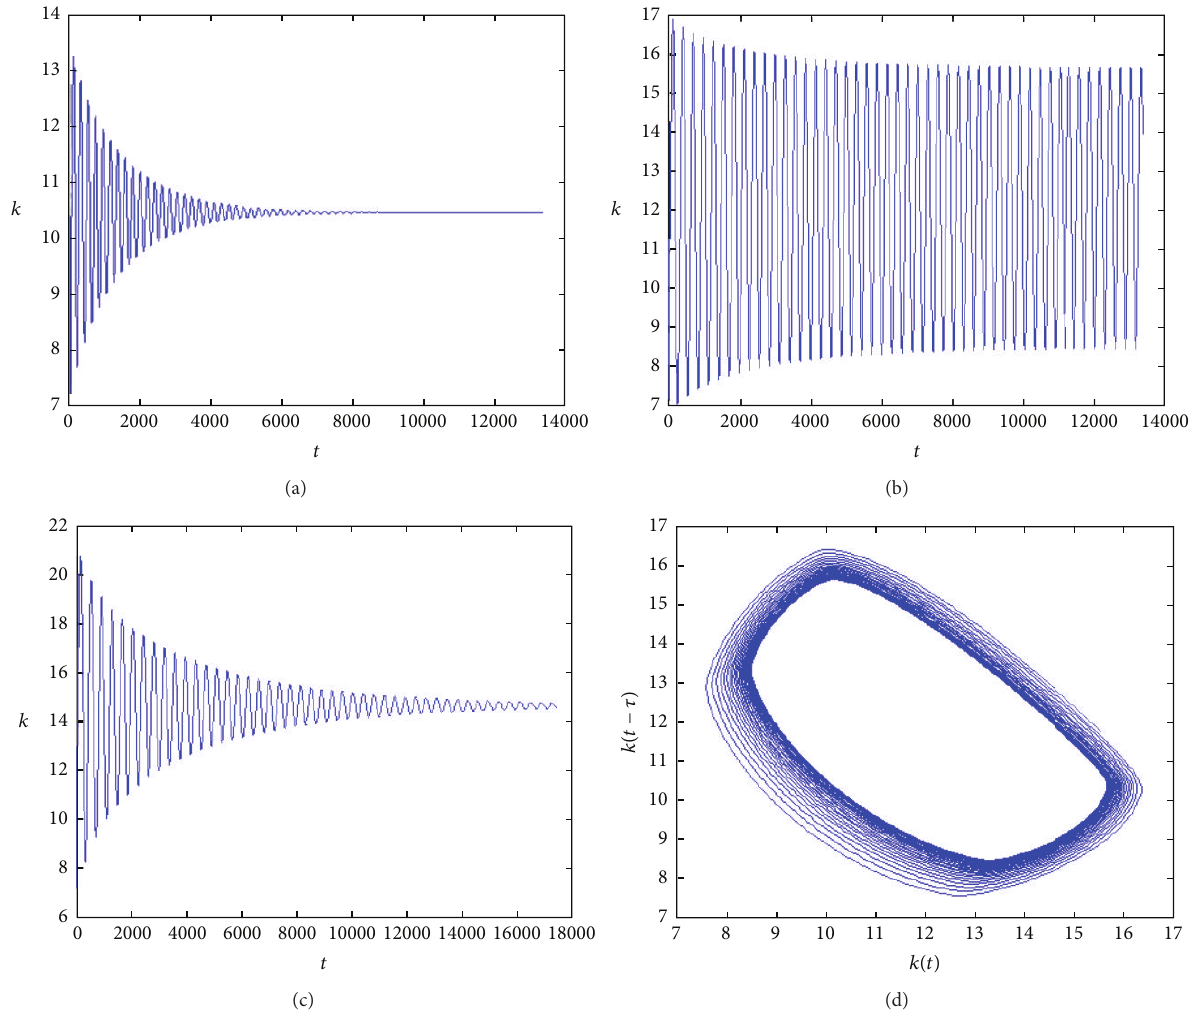
Figure 2: (c) The time evolution of the function 𝑘(𝑡) for 𝜏 = 60 (a); 𝜏 ≅ 87 (b); 𝜏 = 120 ; (d) attracting limit cycle in the plane 𝑘(𝑡) , 𝑘(𝑡 − 𝜏)